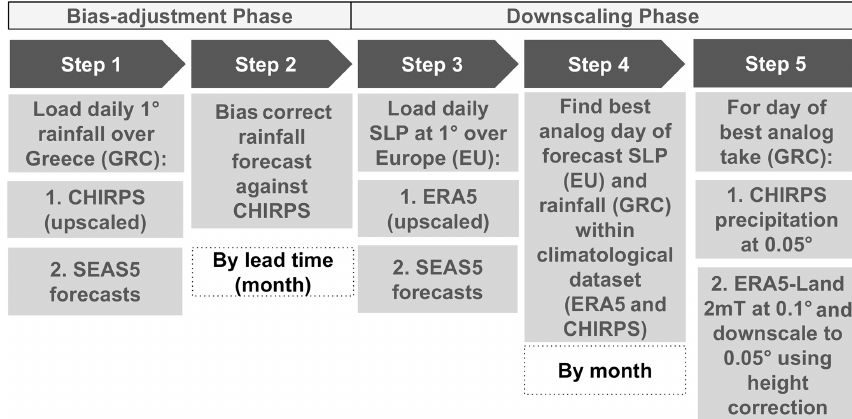
Figure 13. Scheme of the necessary steps to obtain bias-adjusted and downscaled input. The abbreviations used are SLP, SEAS5, EU (Europe), and GRC (Greece).